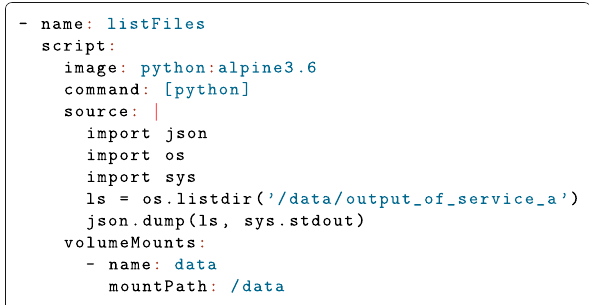
Fig. 23 Example of an additional workflow step in Argo converting a list of files to a JSON array